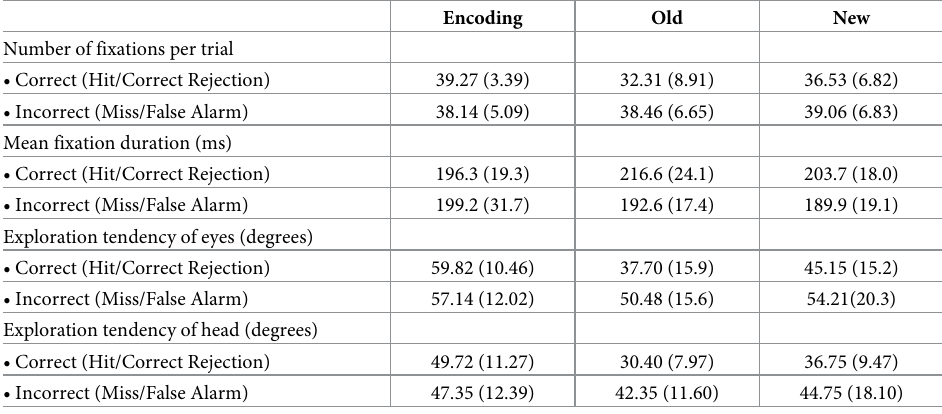
Table 4. Means and standard deviations of general eye movement